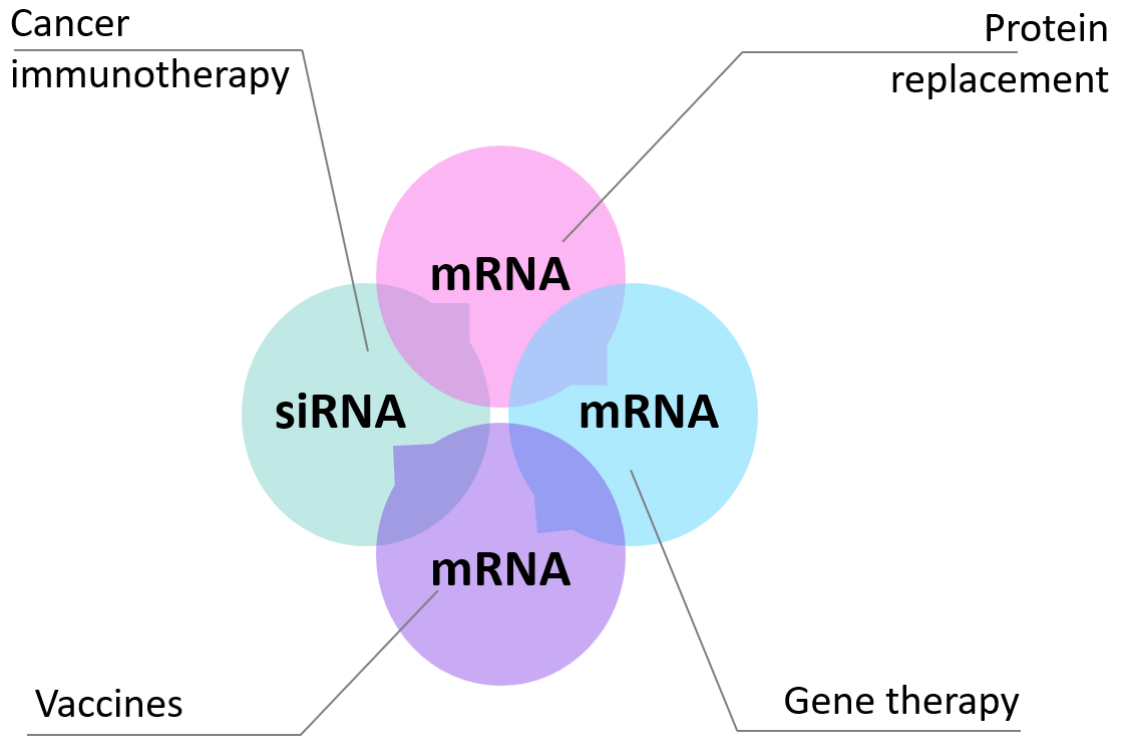
Figure 2. Lipid nanoparticle-mediated delivery of oligonucleotides and mRNA therapeutics. RNA lipid nanoparticle technology can be used to both induce and inhibit gene product expression. In particular, in neoplasia, protein antigen expression can be used for immunotherapy, creating targets for host antitumor immune responses. At the same time, siRNA can be used to inhibit the specific expression of malignant genes.